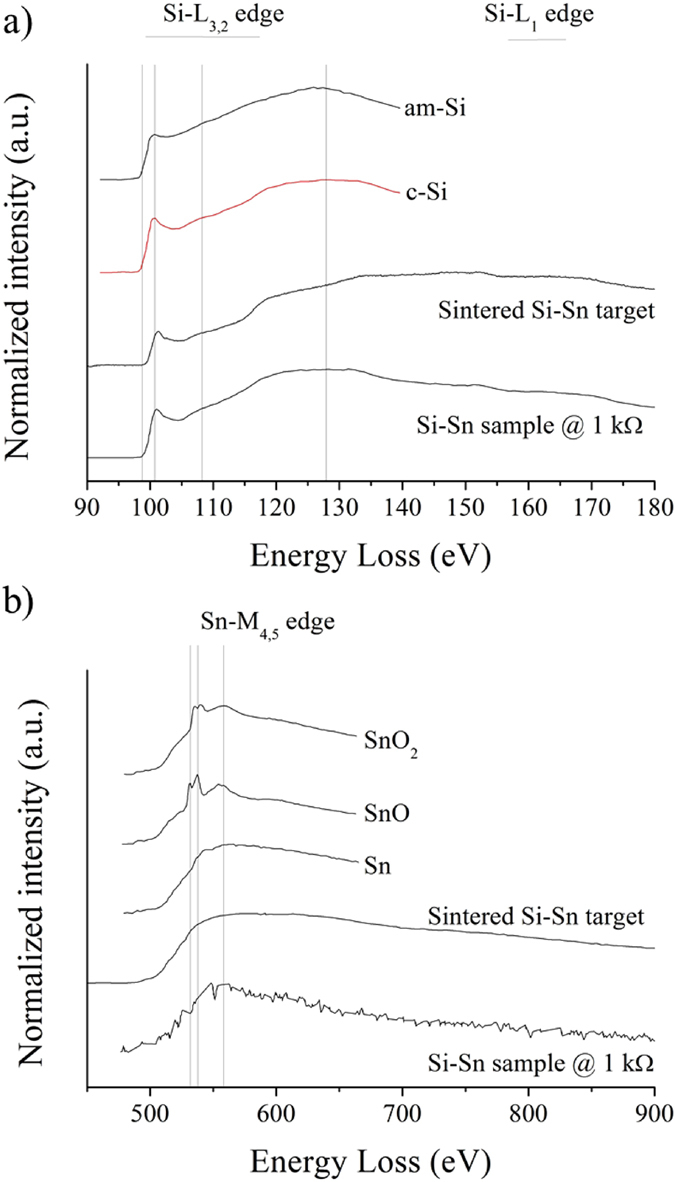
(a) EEL spectra at the Si-L3,2 edge of a representative sample synthesized with a current of 10 A. Reference spectra (amorphous and crystalline silicon and amorphous SiO2) taken from4 are given for comparison. (b) EEL spectrum at the Sn-M4,5 edge of a representative sample synthesized with a current of 10 A. Reference spectra taken from5 are given for comparison.